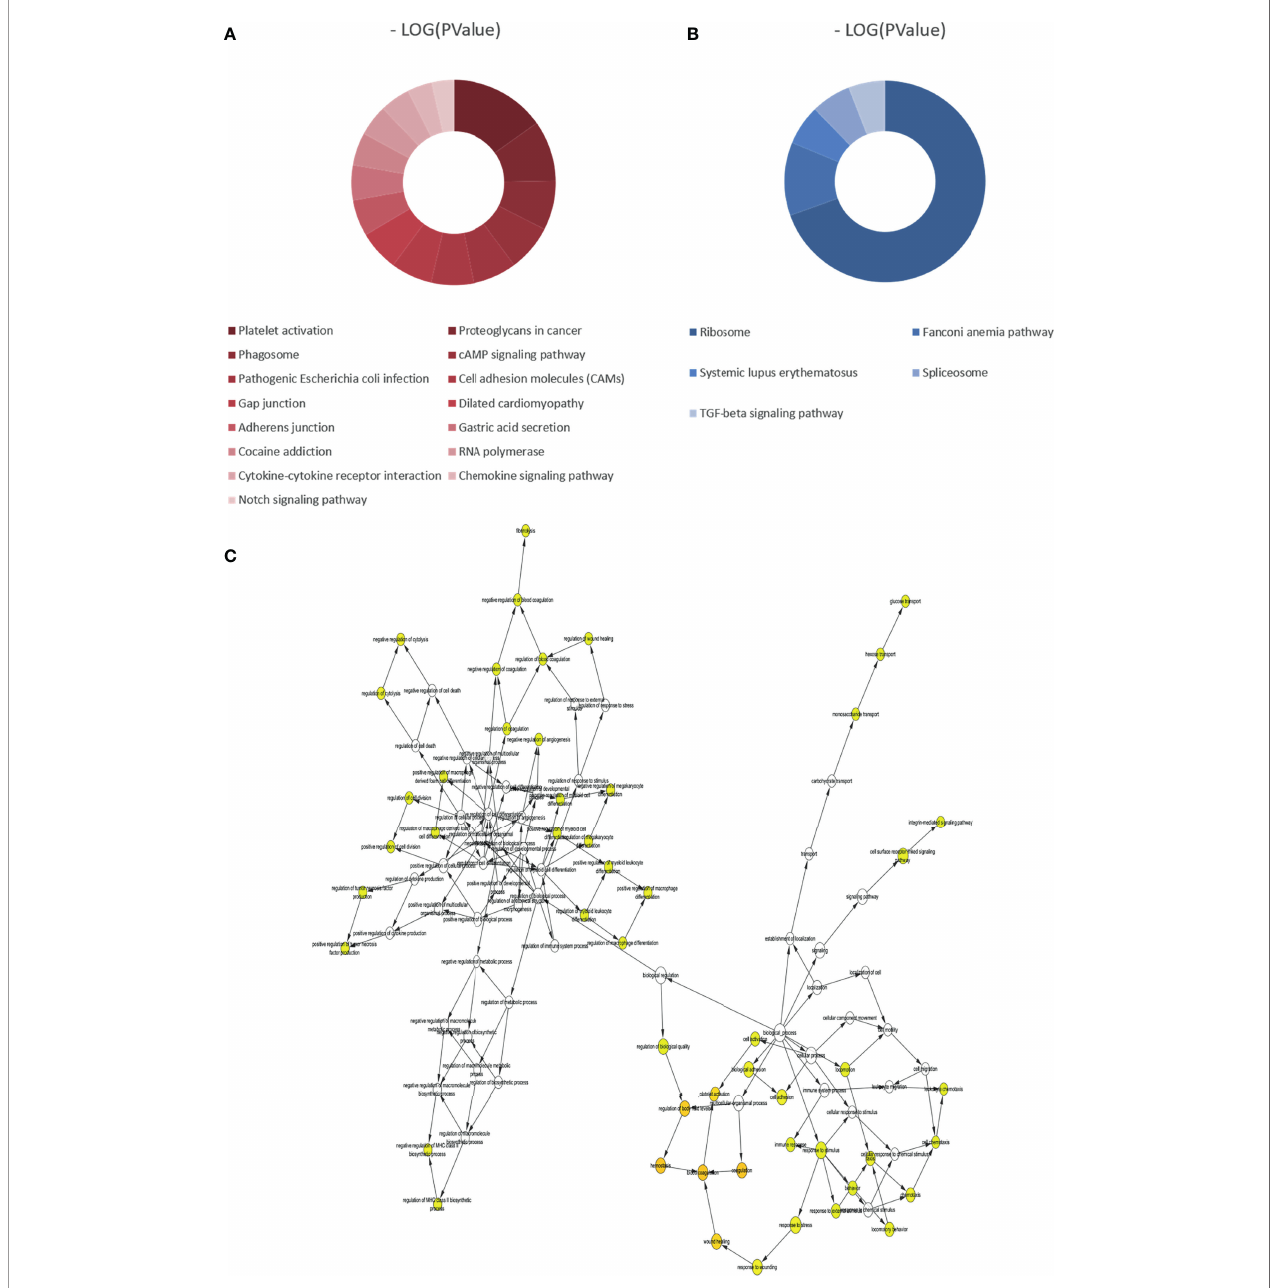
FIGURE 3 | Kyoto Encyclopedia of Genes and Genomes (KEGG) analyses of all differentially expressed genes (DEGs) and biological process analysis of the hub genes (degree >10). (A) KEGG pathways of upregulated DEGs. (B) KEGG pathways of downregulated DEGs. (C) The biological process analysis of hub genes (degree >10). The color depth of nodes refers to the corrected p -value of ontologies. The size of nodes refers to the numbers of genes that are involved in the